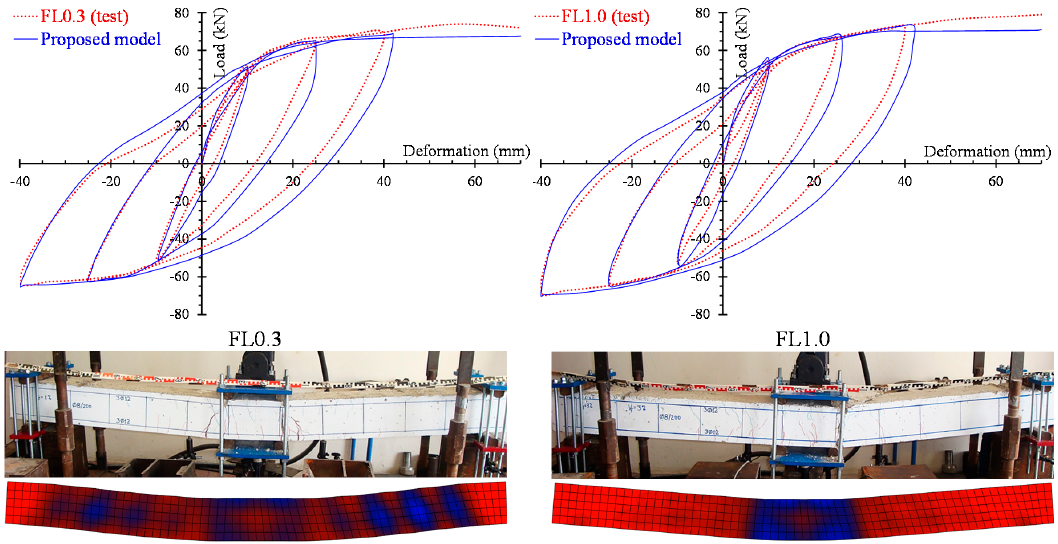
Figure 14. Full hysteretic response and cracking pattern at failure of the slender beams (group “FL” Figure 14. specimens).